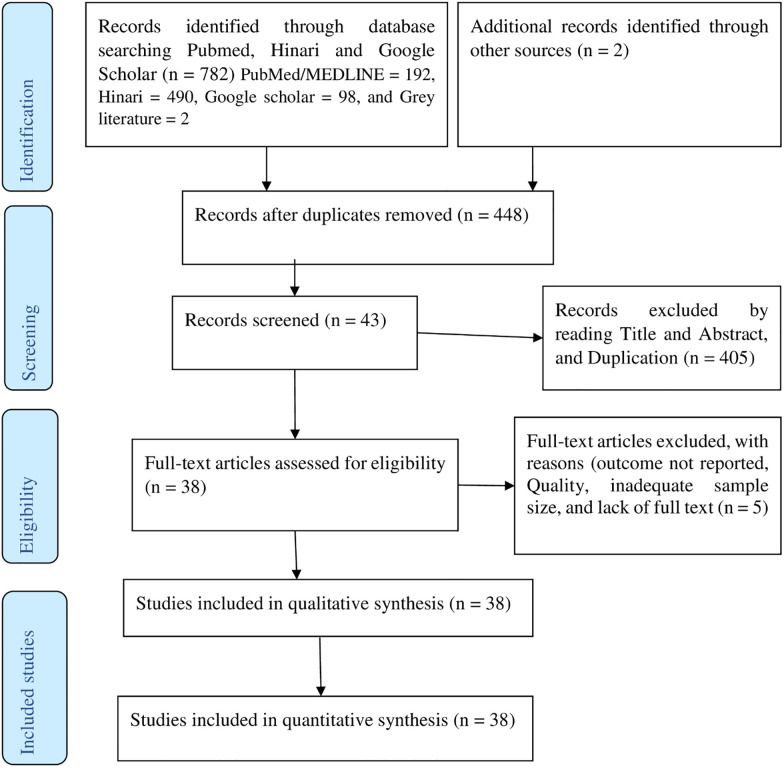
PRISMA flow diagram of article selection for systematic review and meta-analysis of the prevalence of hypertension and its determinants in Ethiopia.